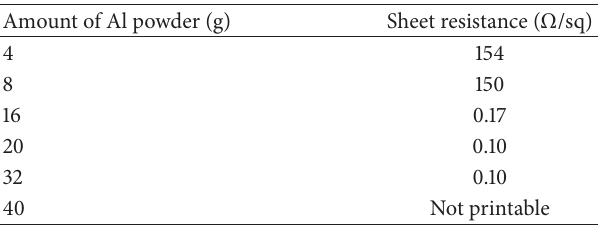
Table 2: Dependence of the sheet resistance on the amount of Al used in “ Paste 1. ”